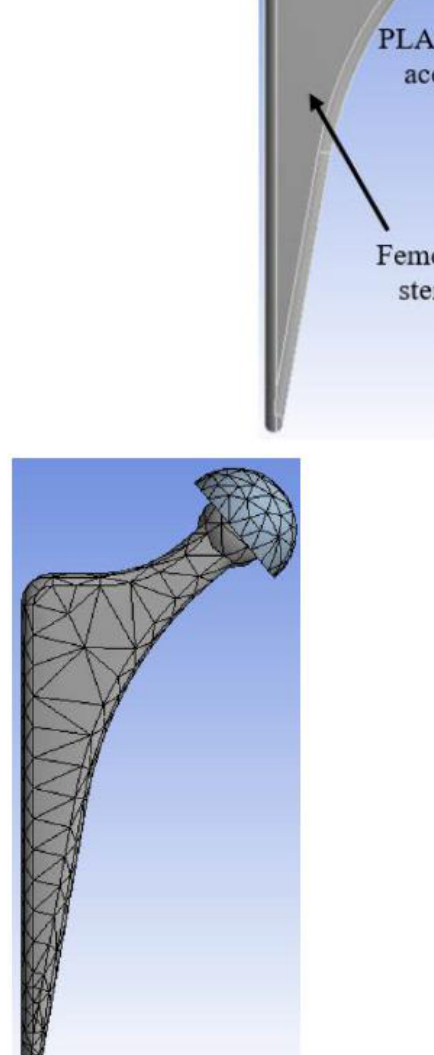
Figure 3. Schematic of the artificial hip joint and the finite element model of the hip joint with and without meshing.